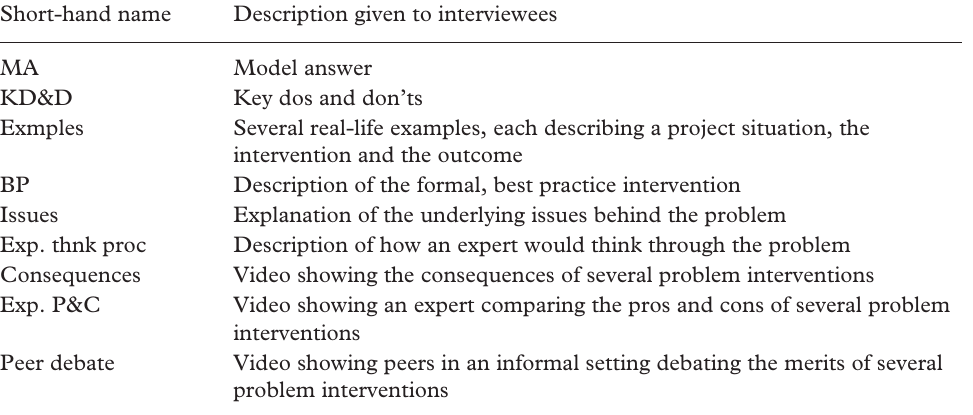
Table 2. Nine hypothetical non-verificational feedback designs evaluated by